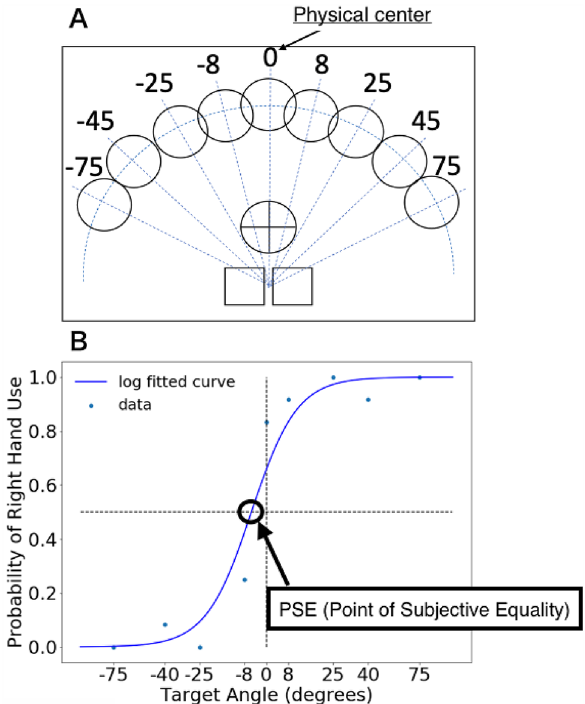
Figure 2. Target positions and point of subjective equality of hand choice. ( A ) Target positions. Starting position (bottom two squares), fixation point (central “+” mark), and the nine possible targets. The targets were set at angles of 0°, 8°, 25°, 45°, and 75° to either side of the mirror’s midline. ( B ) Point of subjective equality (PSE). The probability of choosing the right hand for each target is fitted to a logistic function for each participant. The horizontal axis indicates the target angle, where 0 is the midline as the physical centre (positive degree means rightward rotation and negative degree means leftward rotation relative to the midline). The vertical axis indicates the rate of right-hand selection. PSE, the estimated location at which participants were equally likely to use the right and left hand, was thus